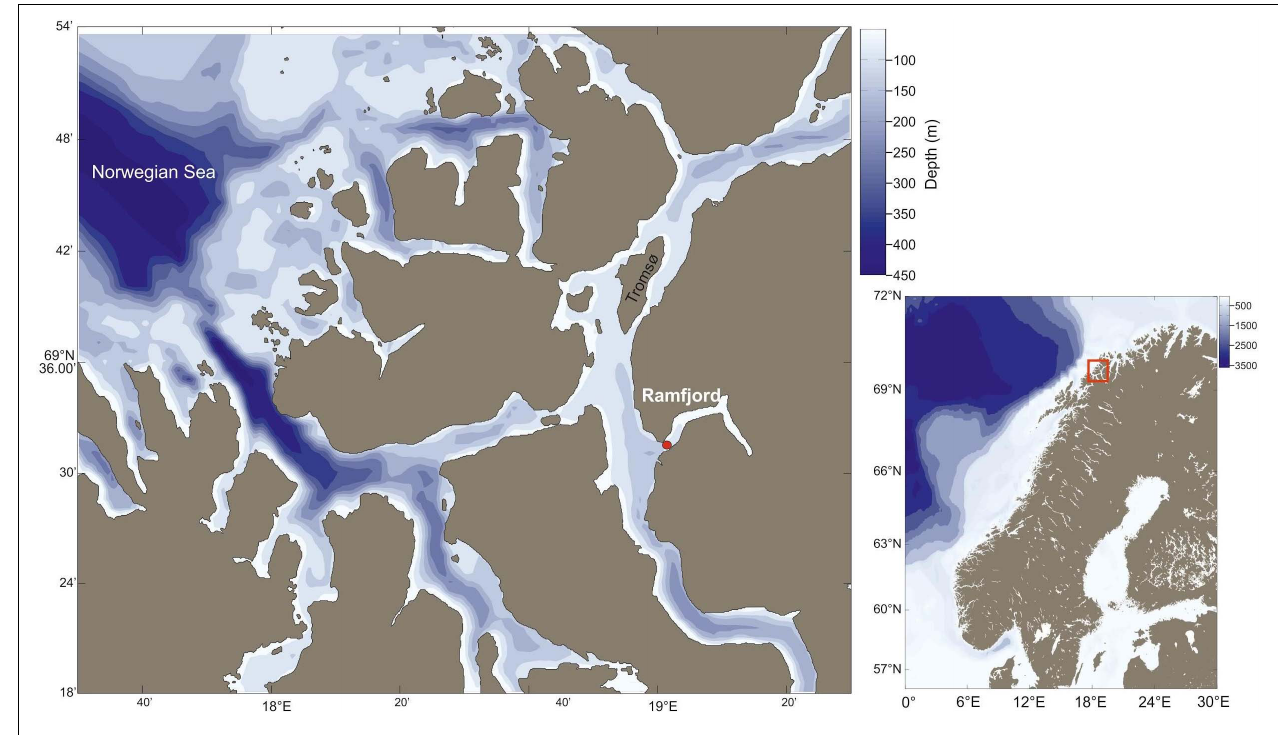
FIGURE 1 | Map of study area. Red dot marks the main study site at the entrance of Ramfjord.